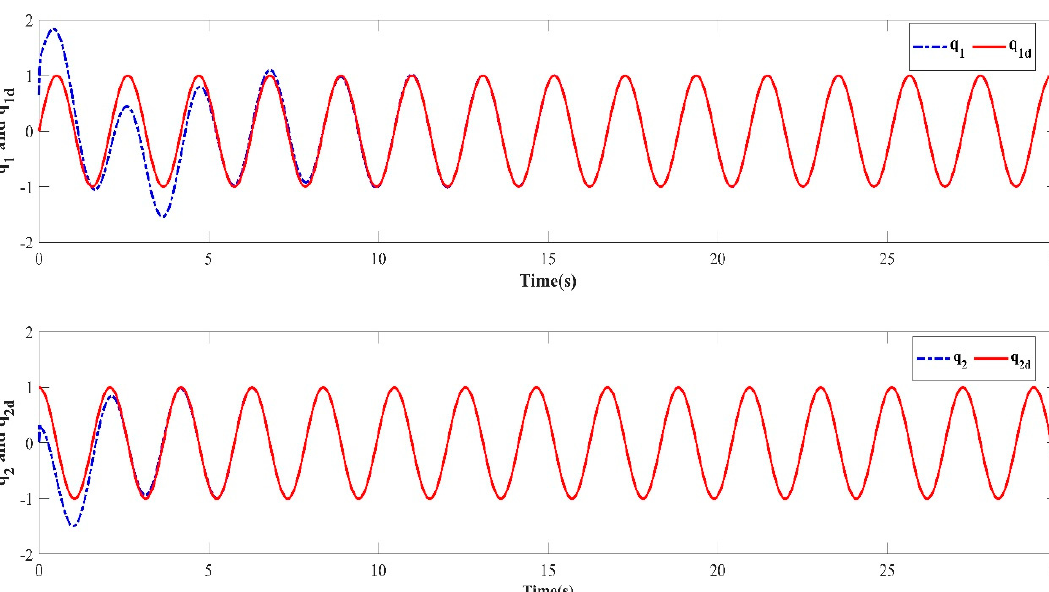
Figure 5. Learning trajectory in the fifth